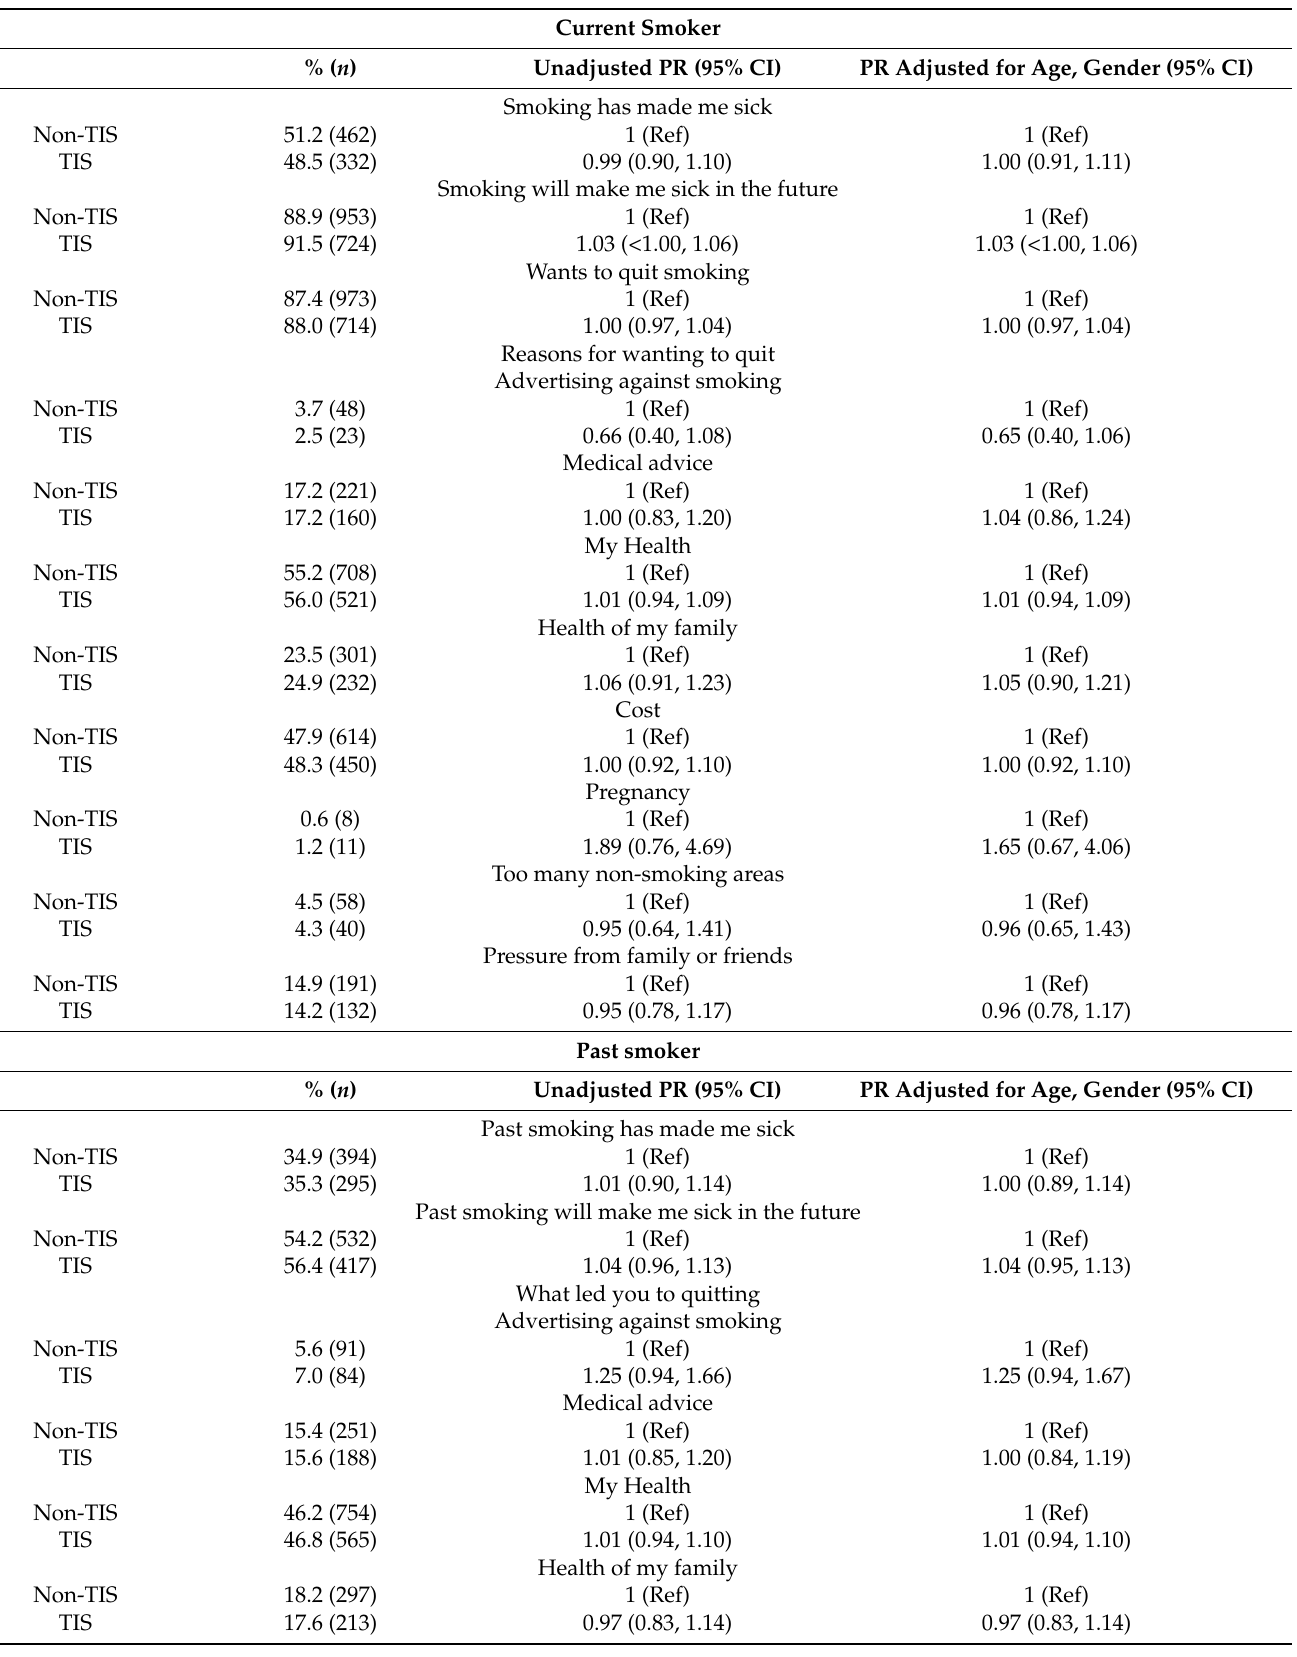
Table 6. Relationships between TIS and smoking-related attitudes, among current smokers and among past